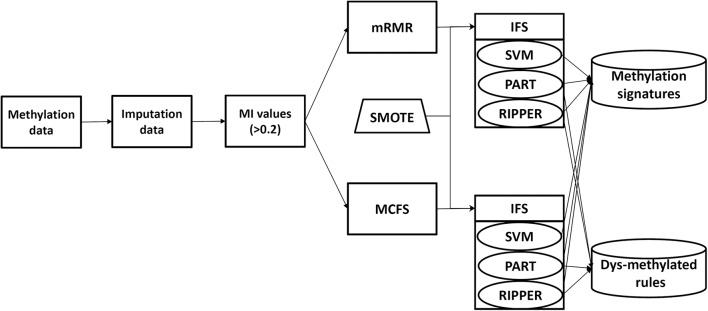
Analysis framework.